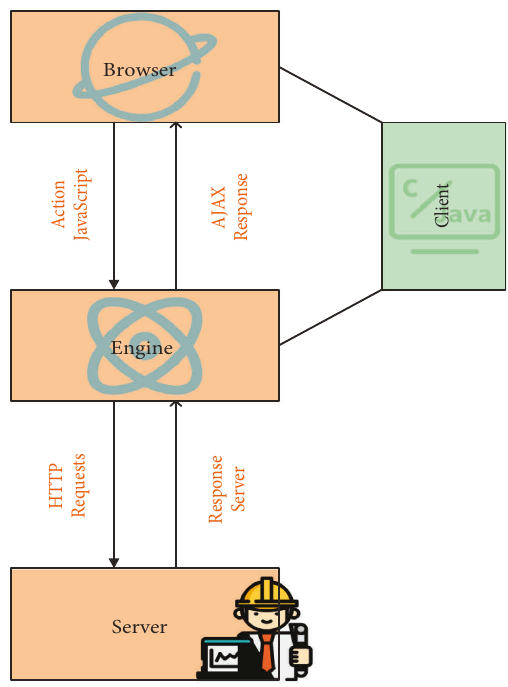
Figure 5: AJAX working principle diagram.